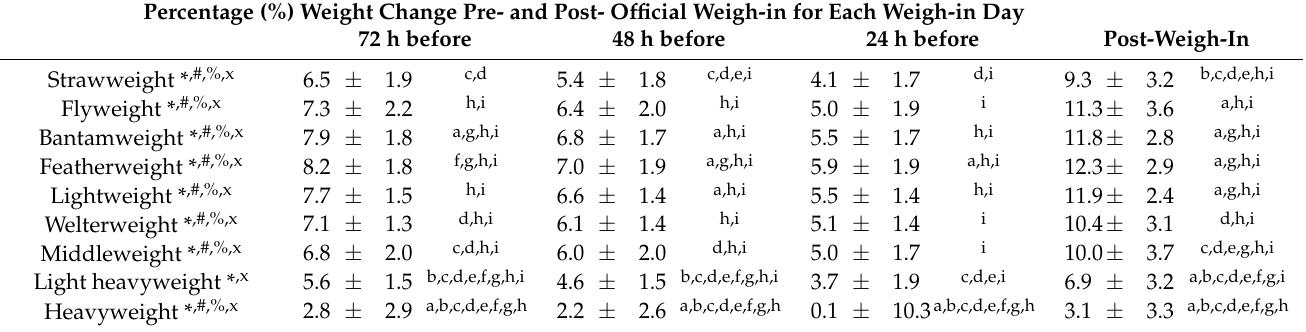
Table 4. Percentage Weight Changes by Weight Class (Fixed Effects) for Each Weigh-in Day (Random